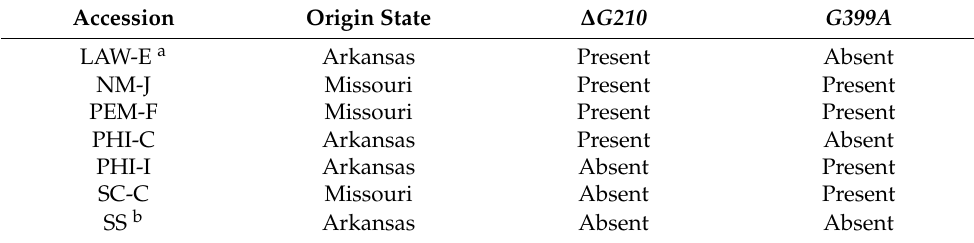
Table 1. Expected mutation profile of A. palmeri field accessions used in the experiment. Accession Origin